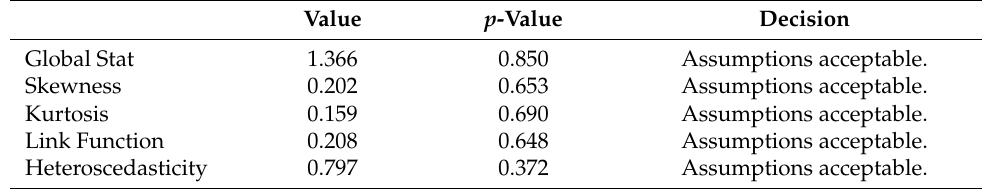
Table 3. Diagnosis of the regression